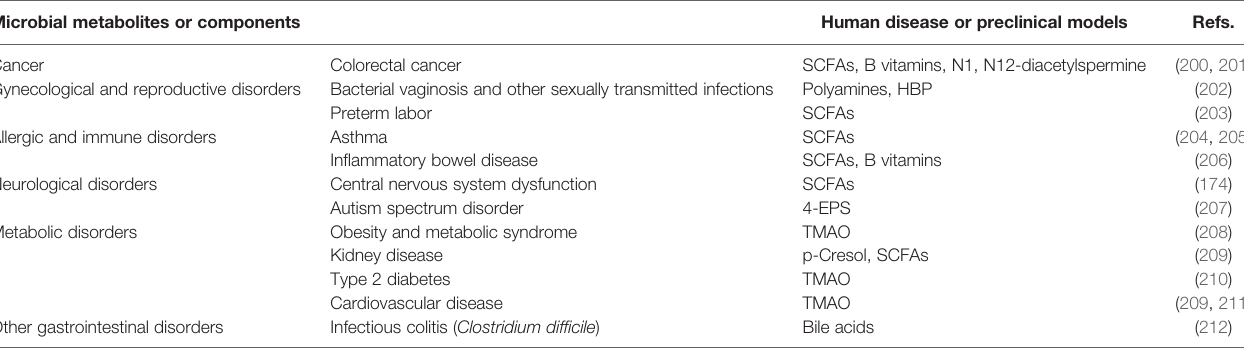
TABLE 6 | Microbial metabolites or components related to diseases. Microbial metabolites or components Human disease or preclinical models